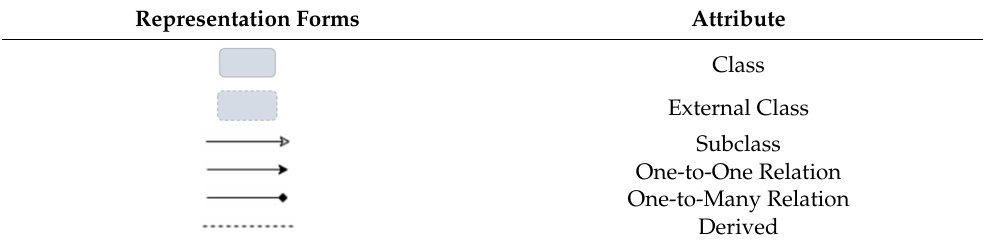
Table 2. Representation forms used in the ontology modeling structure.